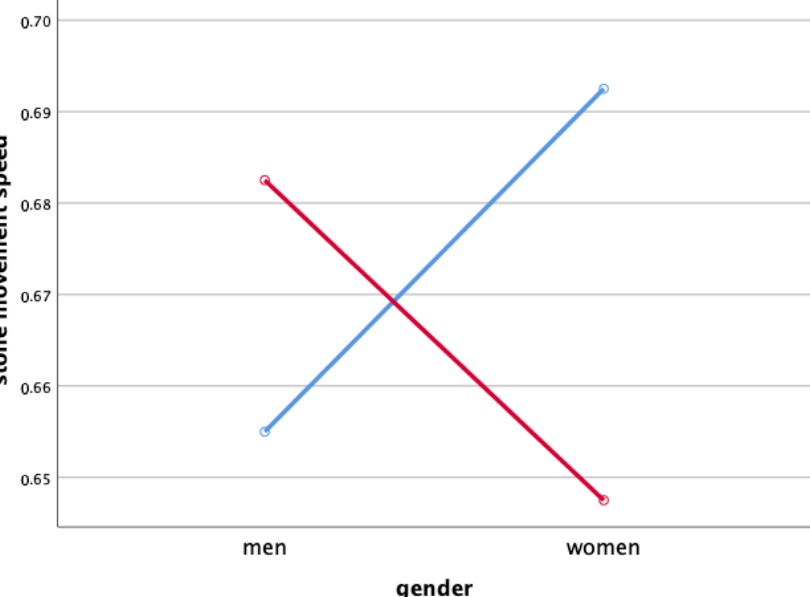
Figure 2. Stone Movement Speed When Sweeping (m/s). Red line: along the axis of motion, blue line: perpendicular to the axis of motion.